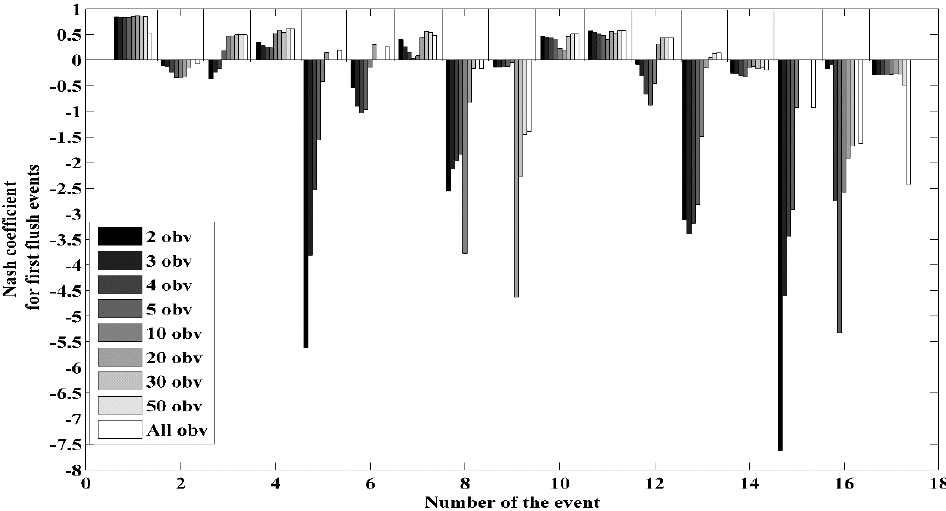
Figure 14. Bar plot of the Nash–Sutcliffe coefficients calculated for first flush events. Water 2016 , 8 , 312